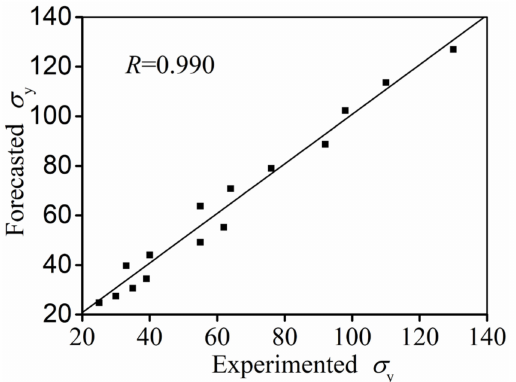
Figure 8. Correlation analysis between forecasted and experimented values of σ y